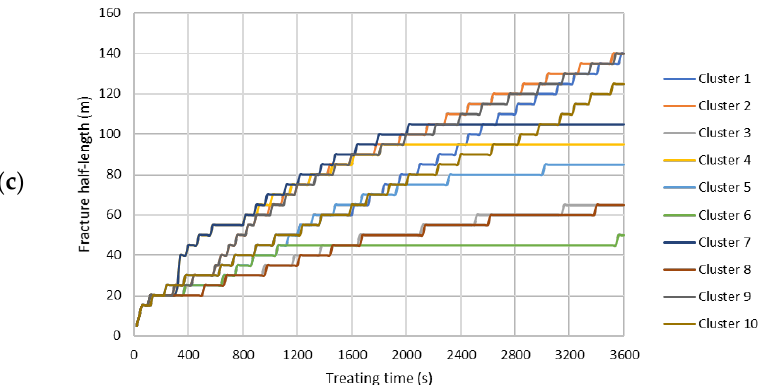
Figure A2. Fracture half-length of each cluster during the hydraulic fracturing treatment. ( a ) Slick water case. ( b ) NG foam case. ( c ) Hybrid NG/NG foam case.